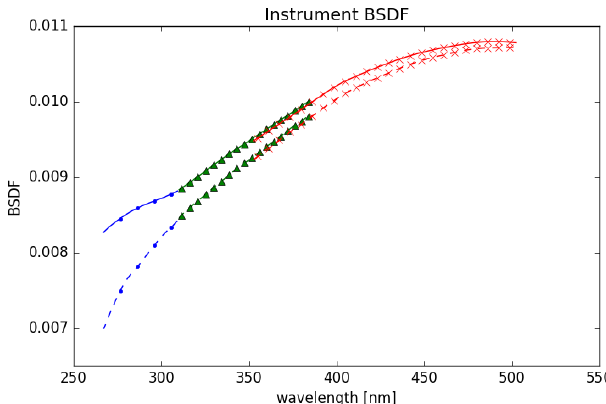
Figure 23. Instrument BSDF using the QVD for the UV1 (blue dots), UV2 (green triangles), and VIS (red crosses) channels. It can be seen that the BSDF matches quite well in the overlap regions be- tween the bands at the start of the mission (solid line) and late in the mission (dashed line).